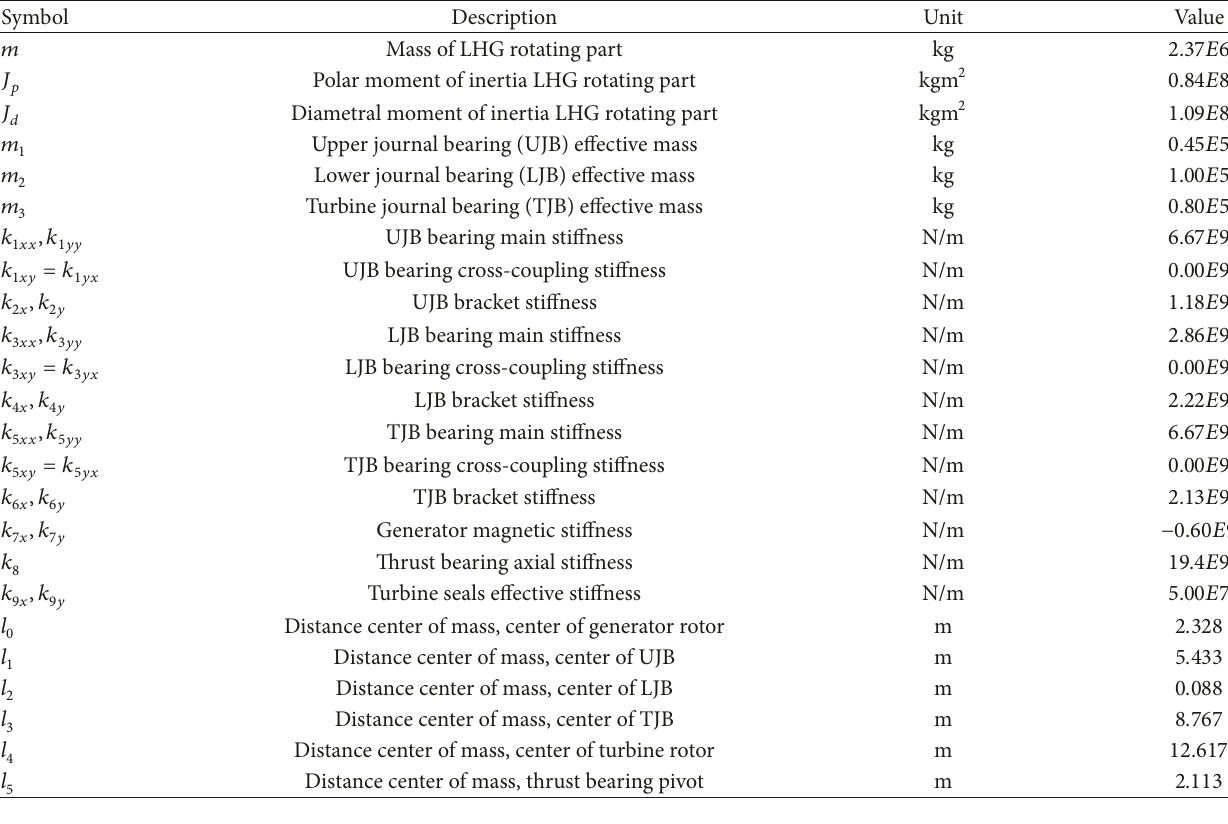
Table 2: Parameters of the rigid body model.